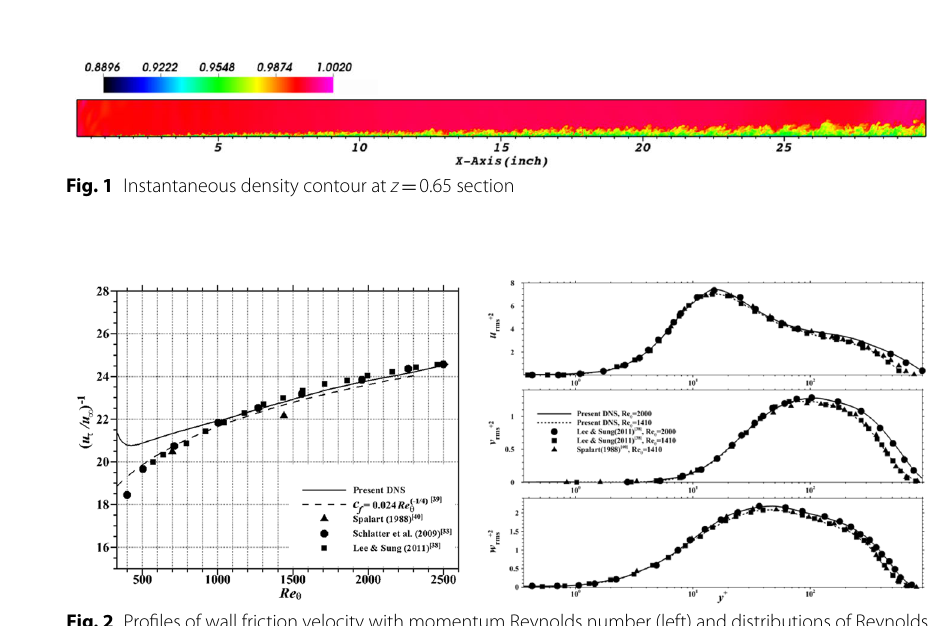
Fig. 2 Profiles of wall friction velocity with momentum Reynolds number (left) and distributions of Reynolds stresses at